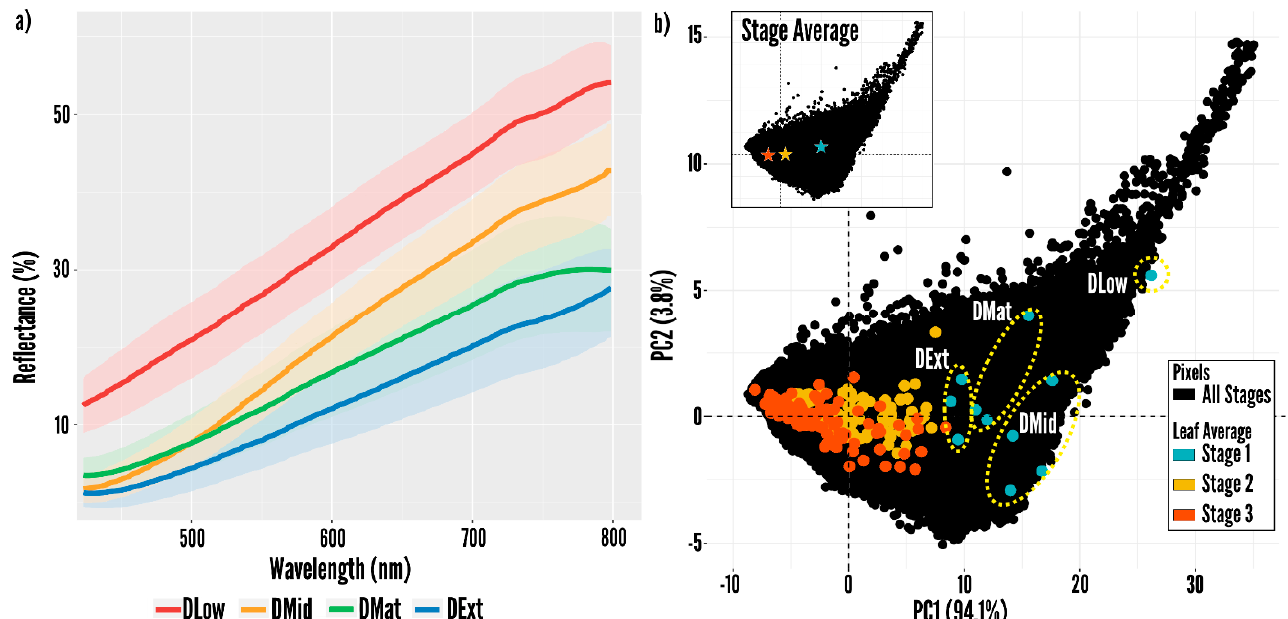
Figure 4. ( a ) Average reflectance (line) and standard deviation (ribbon) of all pixels for all leaves per decay group at Stage 1 collected by CRHSI; ( b ) first and second principal components of approxi- mately 600,000 randomly selected pixels as black dots. Colored dots are the average spectra of each leaf disc. The yellow ellipses circle all leaves belonging to the same decomposition group, with the group name indicated in white text. The top left inset shows the predicted principal analysis coordinates for the average spectra of all pixels from each stage (all decomposition groups).